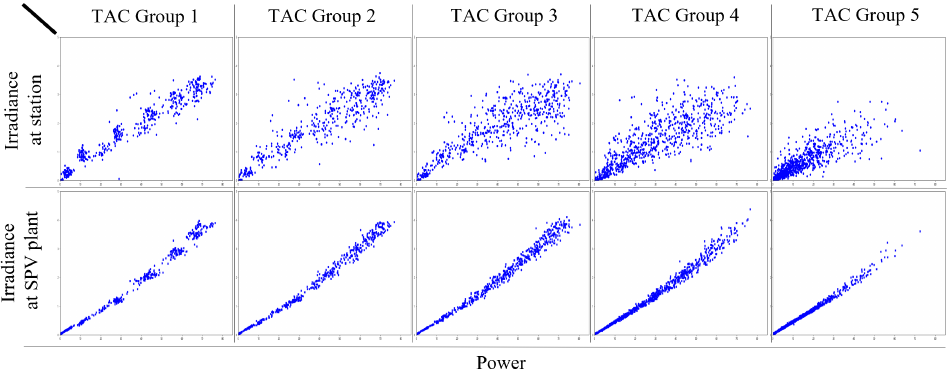
Figure 5. Two irradiances and the Vision college SPV Power data plots via groups of Total Amount of Cloud (TAC) at Jeonju meteorological station. Upper 5 plots are made with irradiance at meteoro- logical station and lower 5 plots are made with irradiance at SPV